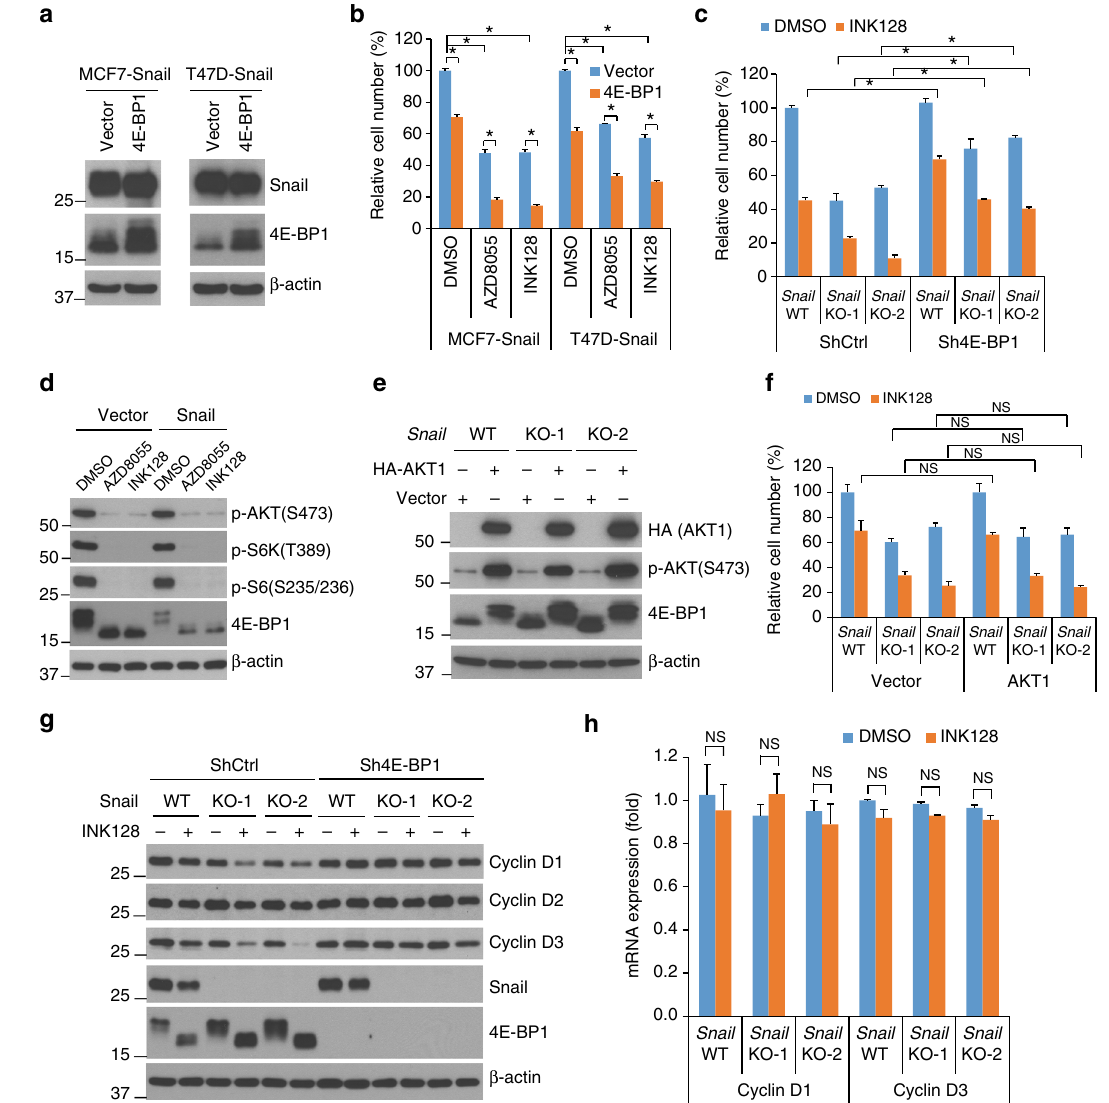
Fig. 6 Snail modulation of cancer cell sensitivity to mTORkis is mediated at the level of 4E-BP1. a , b Snail-expressing MCF7 or T47D cells stably expressing exogenous 4E-BP1 or vector control were assessed by western blot analysis for the indicated proteins a or by cell growth analysis after 72 h of treatment with 100 nM AZD8055, 100 nM INK128, or DMSO as control b . c Snail WT or KO HCT116 cells stably expressing 4E-BP1 shRNA or control shRNA were assessed for cell growth after 72 h of treatment with 100 nM AZD8055, 100 nM INK128 or DMSO as control. The results are expressed as a percentage of cell number relative to the DMSO-treated Snail WT cells expressing control shRNA. d T47D cells with stable expression of Snail or vector control were treated with 100 nM AZD8055, 100 nM INK128, or DMSO as control for 12 h, followed by western blot analysis for the indicated proteins. e , f Snail WT or KO HCT116 cells expressing AKT1 or vector control were assessed by western blot analysis for the indicated proteins e or by cell growth analysis after 72 h of treatment with 100 nM INK128 or DMSO as control f . The results are expressed as a percentage of cell number relative to the DMSO-treated Snail WT cells expressing vector control. g , h Snail WT or KO HCT116 cells stably expressing 4E-BP1 shRNA or control shRNA were treated with 100 nM INK128 or DMSO as control for 12 h, followed by western blot analysis for the indicated proteins g or by quantitative RT-PCR analysis for mRNA expression of cyclin D1 and cyclin D3 relative to the levels found in DMSO-treated control cells h . All graphic data are presented as mean ± SEM ( n = 3 technical replicates per condition). * P < 0.001; NS, not signi fi cant using Student ’ s t